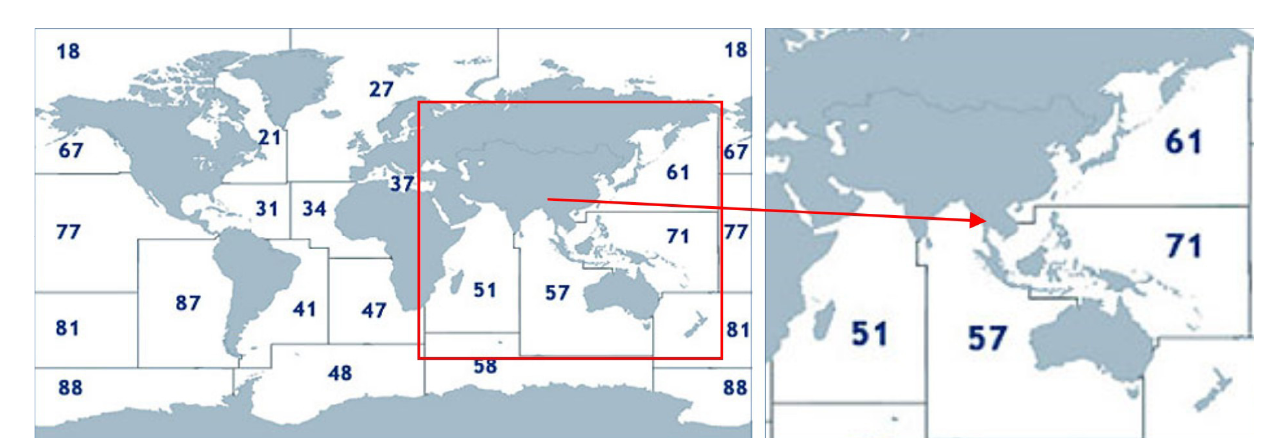
Fig. 1. Map showing the studied FAO fishing